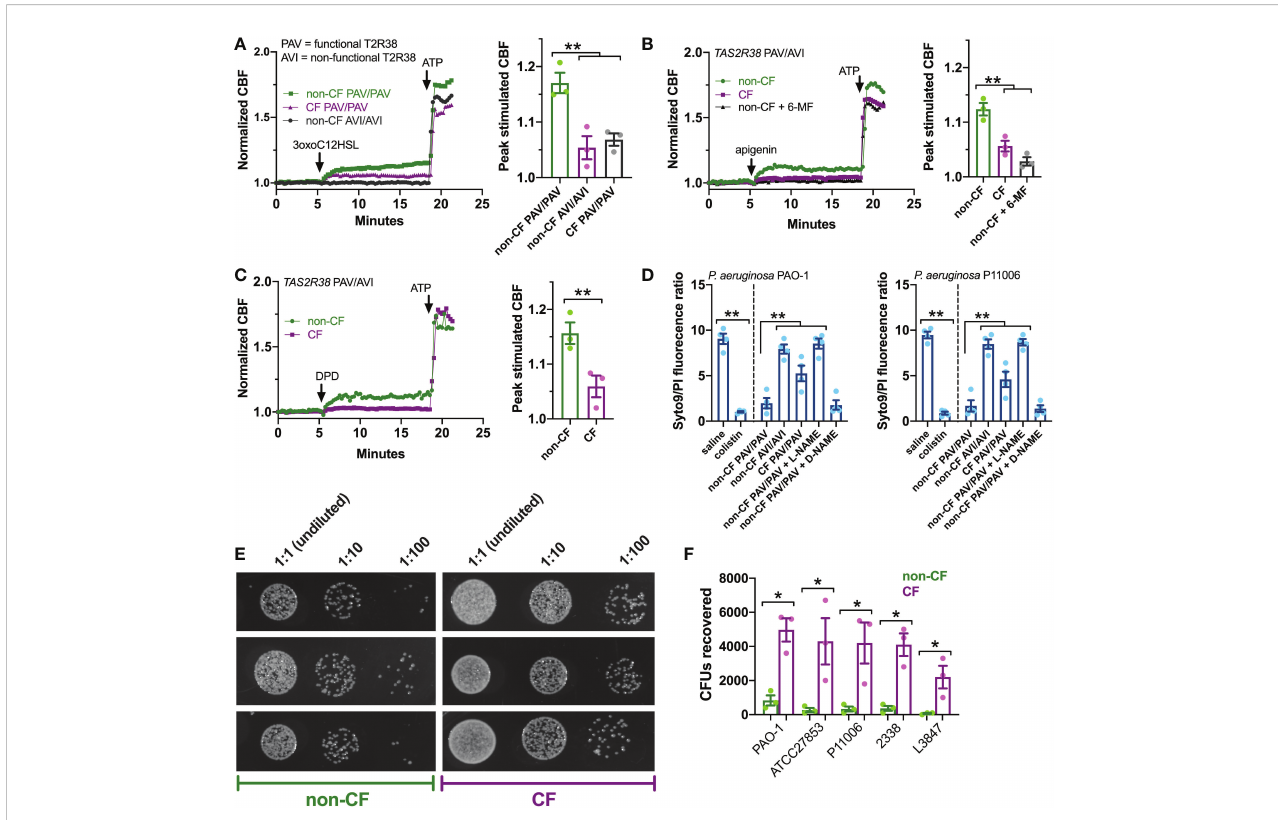
FIGURE 5 T2R ciliary and antibacterial responses are reduced in CF patient ALIs. (A-C) Whole- fi eld ciliary beating was quanti fi ed during stimulation with T2R38 agonist 3oxoC12HSL, apigenin, and diphenhydramine (DPD). Representative traces (left) and bar graphs showing independent experiments using ALIs from separate patients (right; n = 3) are shown. CF cells exhibited reduced ciliary responses vs non-CF cells; p <0.01 by one-way ANOVA with Bonferroni posttest ( A,B ) or Student ’ s t test (C) . ALIs in A were genotyped as TAS2R38 PAV/PAV (functional) or AVI/AVI (non-functional). ALIs in B and C were from PAV/AVI patients. T2R14 agonist 6-methoxy fl avanone was used as a control for apigenin as described earlier in the text. (D) Bacteria Syto9 (live) and propidium iodide (dead) staining were quanti fi ed following bacterial killing assays as described in the text. Saline and antibiotic colistin were used as negative and positive controls, respectively. Signi fi cance determined by one-way ANOVA with Bonferroni posttest; **p<0.01. CF cells killed less bacteria (higher Syto9/PI ratio) than non-CF cells. Non-CF cell killing was reduced by L-NAME but not inactive D-NAME. Both lab PAO-1 and clinical P11006 strains were used. (E) Images of PAO-1 CFUs recovered from three CF and non-CF ALIs from individual patients. (F) Quanti fi cation of independent experiments (n=5) as in E using fi ve strains of P. aeruginosa showing reduced bacterial killing from CF cells. Signi fi cance by one-way ANOVA with Bonferroni posttest; * p